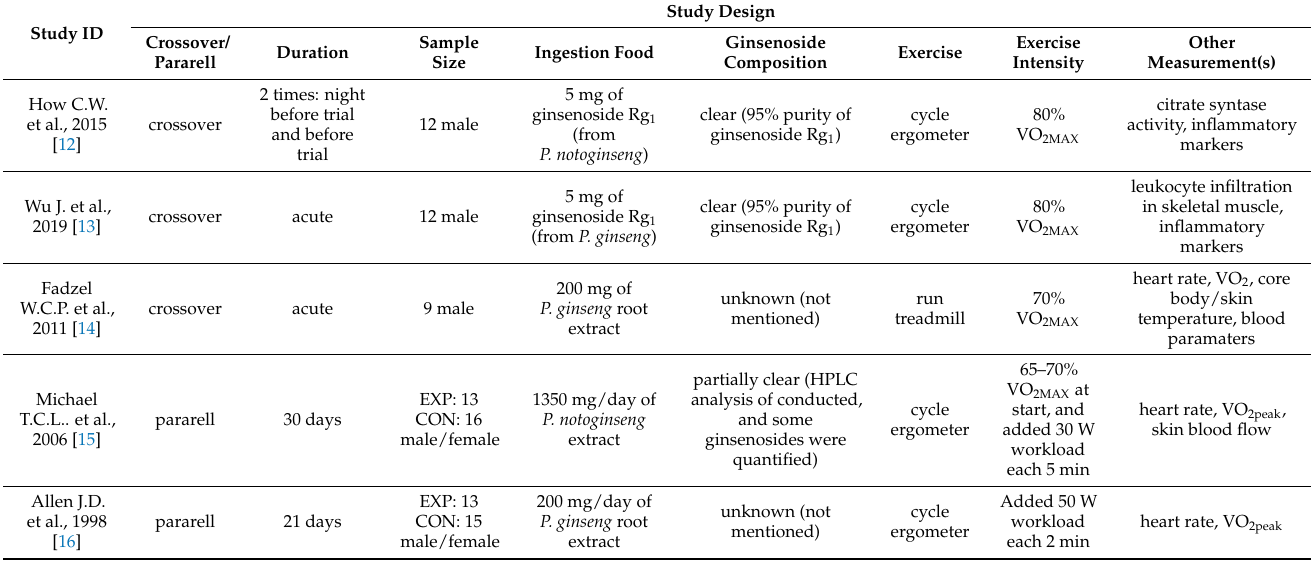
Table 2. Studies included in systematic